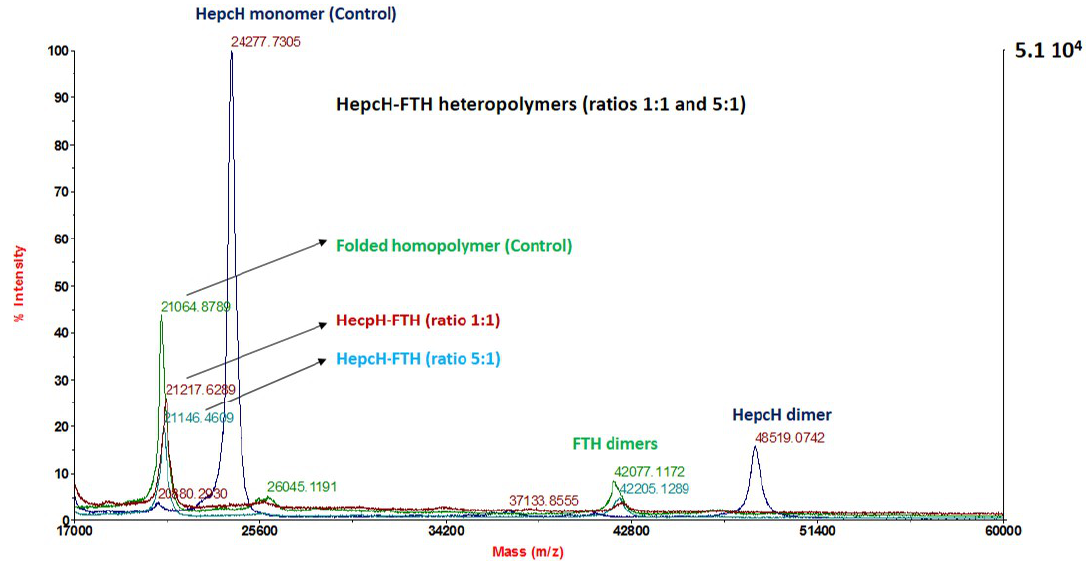
Figure 5. High-resolution MALDI-TOF/TOF mass analysis of the refolded heteropolymer assembled with high HepcH:FTH molar ratio. Folded human ferritin homopolymer (in green). HepcH-FTH heteropolymer, assembled using a molar ratio HepcH:FTH of 1:11 (in red). HepcH-FTH heteropolymer, assembled using a molar ratio HepcH:FTH of 5:1 (in turquoise). HepcH monomer (in dark